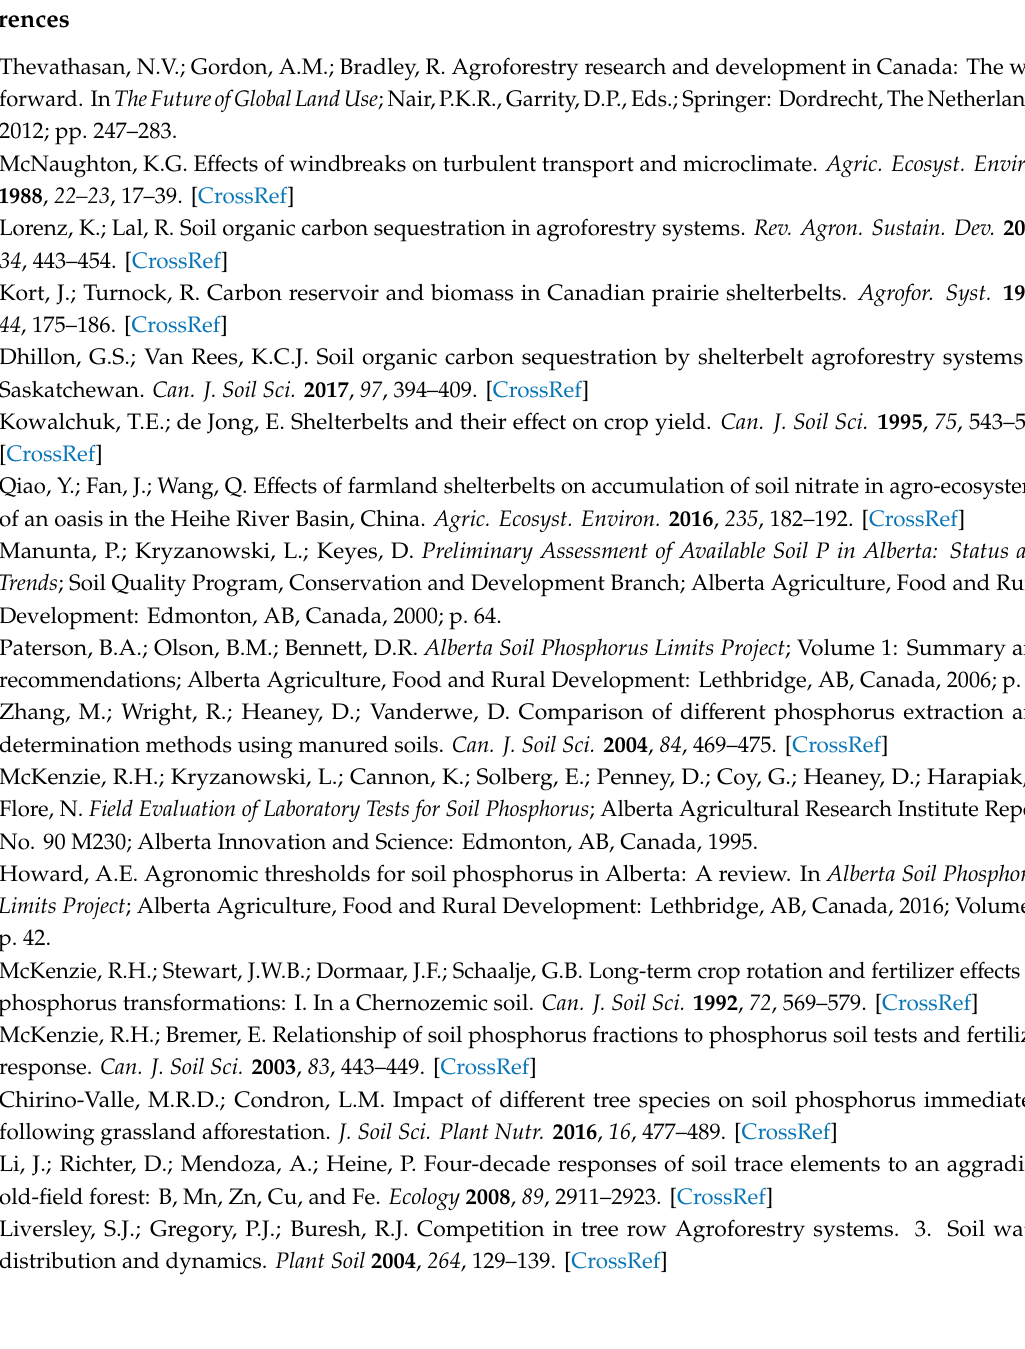
Figure S1: Map of Canada and the Province of Alberta showing the location of six study sites of shelterbelt systems. Figure S2: The relationship between Mehlich-3 extractable P and modified Kelowna extractable P in the 0–30 cm depth of selected cropland and forestland in shelterbelt systems in central Alberta. Figure S3: The relationship between P sorption index and P extracted by the modified Kelowna